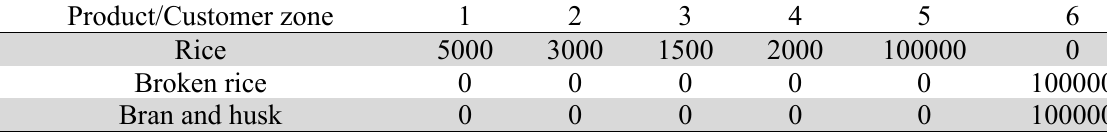
Demands of each customer zone for final products (tonnes) Product/Customer zone